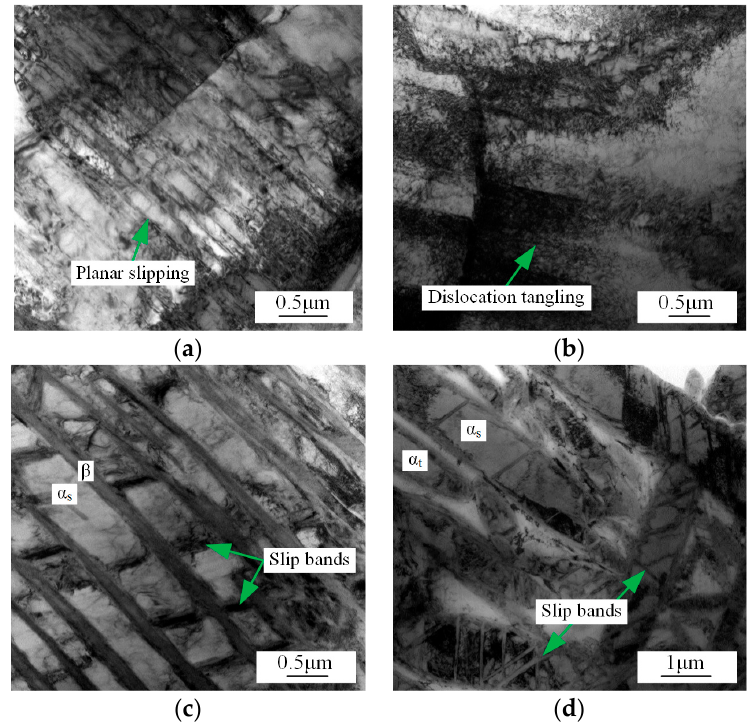
Figure 7. TEM images of deformed microstructure in TA15 alloy: ( a ) planar slipping bands in α p particles, ( b ) dislocation tangling in α p particles, ( c ) shear slip bands of α s in sample S4, ( d ) dense shear slip bands of α s in sample S2.